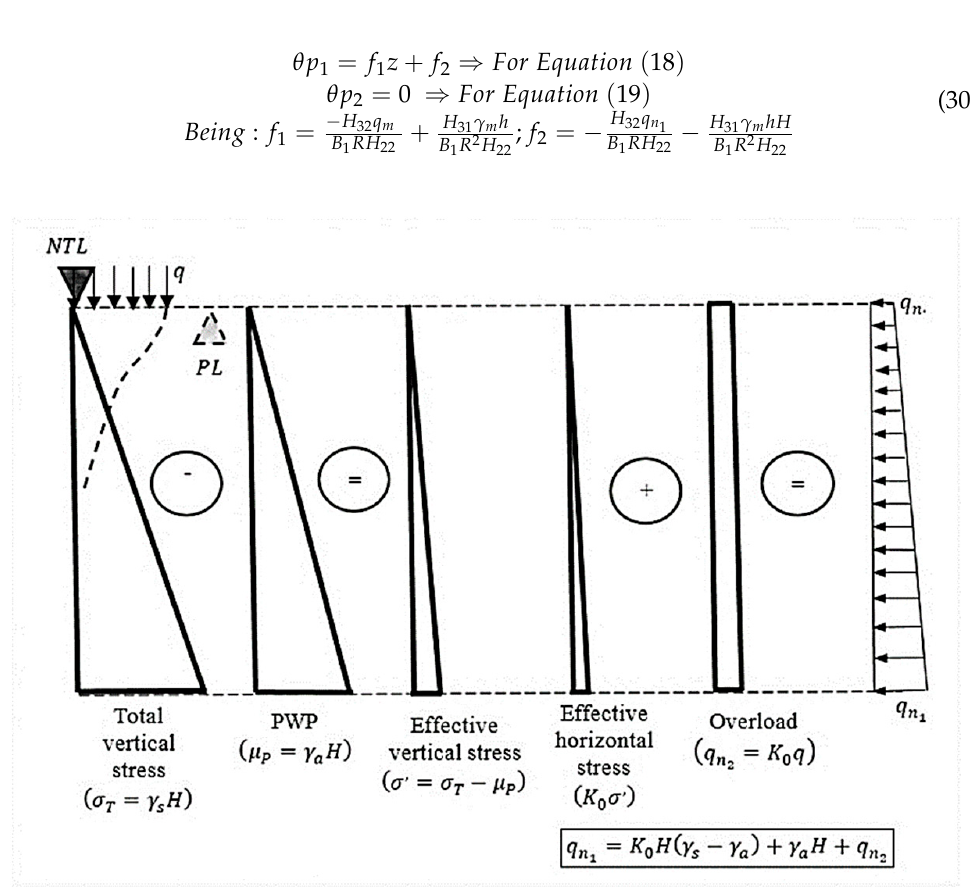
Figure 4. Load model.